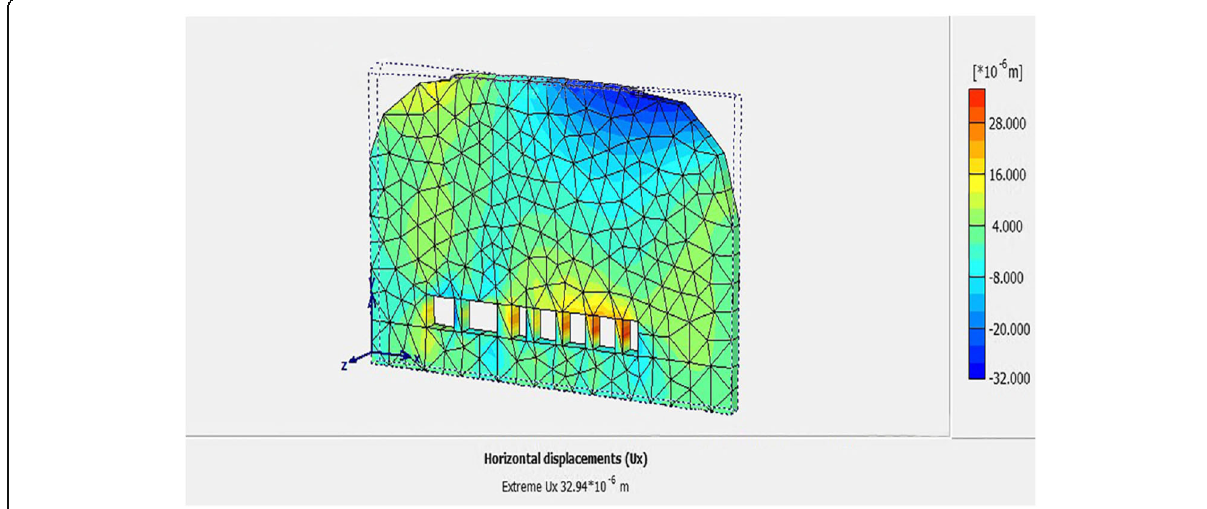
Fig. 23 Horizontal displacements of the support rock pillars in Chamber 3. PLAXIS 3D